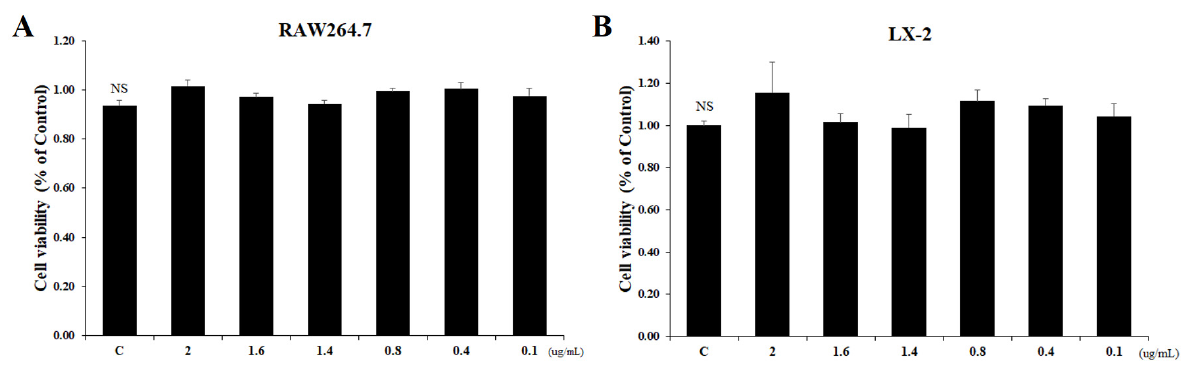
Figure 1. Effects of T β 4 on cell viability measured by an MTT assay. ( A ) RAW264.7 cells; ( B ) LX-2 cells. All data are presented as means ± SEM from triplicate independent experiments. NS Indicates not significantly different with C (control) ( p > 0.05).